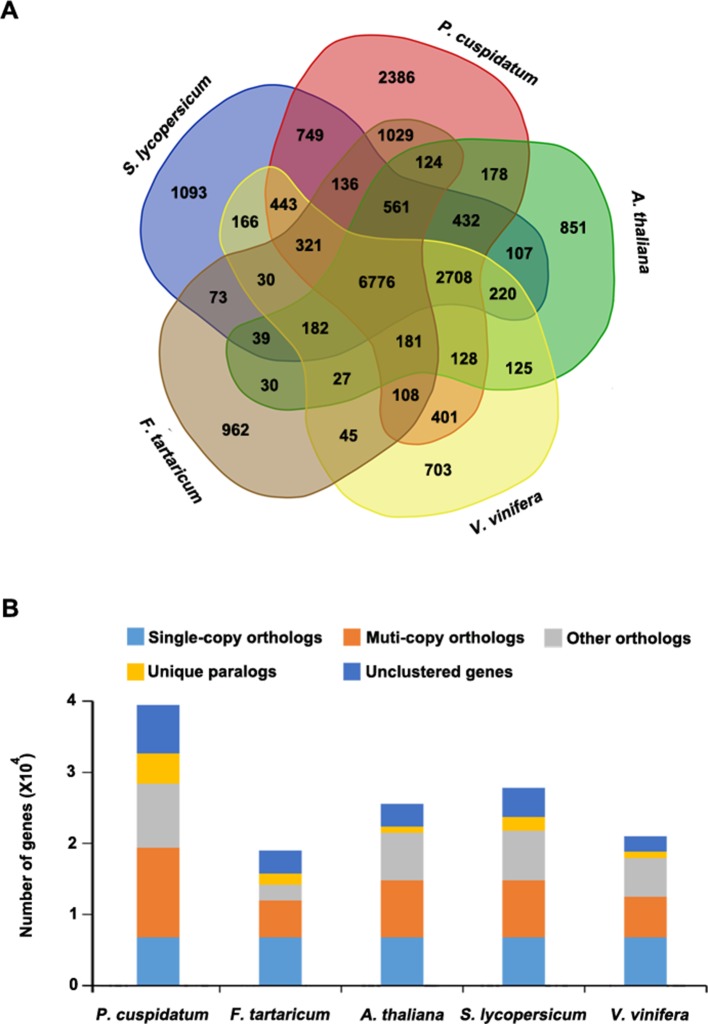
Classification of gene families. (A) Venn diagram showing the number of gene families in five plant species. Each number represents the number of gene families in each species or those shared by different species. The analysis was carried out using OrthoMCL software. (B) Summary of the number of genes in different groups. The genes were parsed from OrthoMCL clustering analysis.